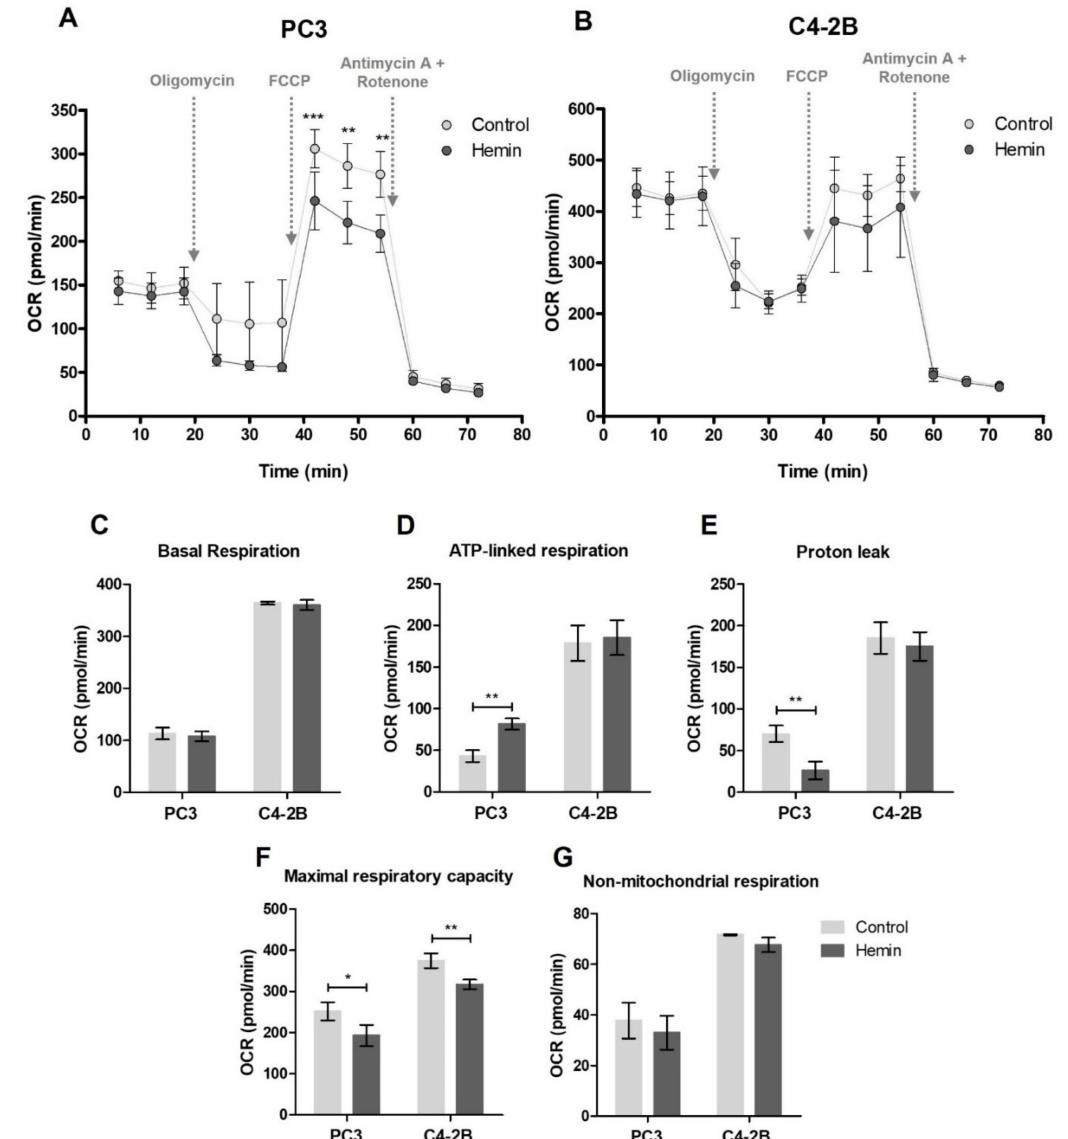
Figure 2. Oxygen consumption in PCa cells after HO-1 induction. ( A ) PC3 and ( B ) C4-2B oxygen consumption rate (OCR) after hemin treatment, determined in basal conditions and in response to 1 µ M oligomycin, 0.25 µ M FCCP for PC3 cells or 0.5 µ M FCCP for C4-2B cells and 0.5 µ M antimycin A + 0.5 µ M rotenone using the Seahorse XF Cell Mito Stress Test Kit (Seahorse Bioscience, USA). Bar graphs showing the quantification of: ( C ) Basal respiration, ( D ) ATP-linked respiration, ( E ) proton leak, ( F ) maximal respiratory capacity and ( G ) non-mitochondrial respiration. Data are presented as mean ± SD of six replicates. Significant differences: * p < 0.05; ** p < 0.01; *** p <